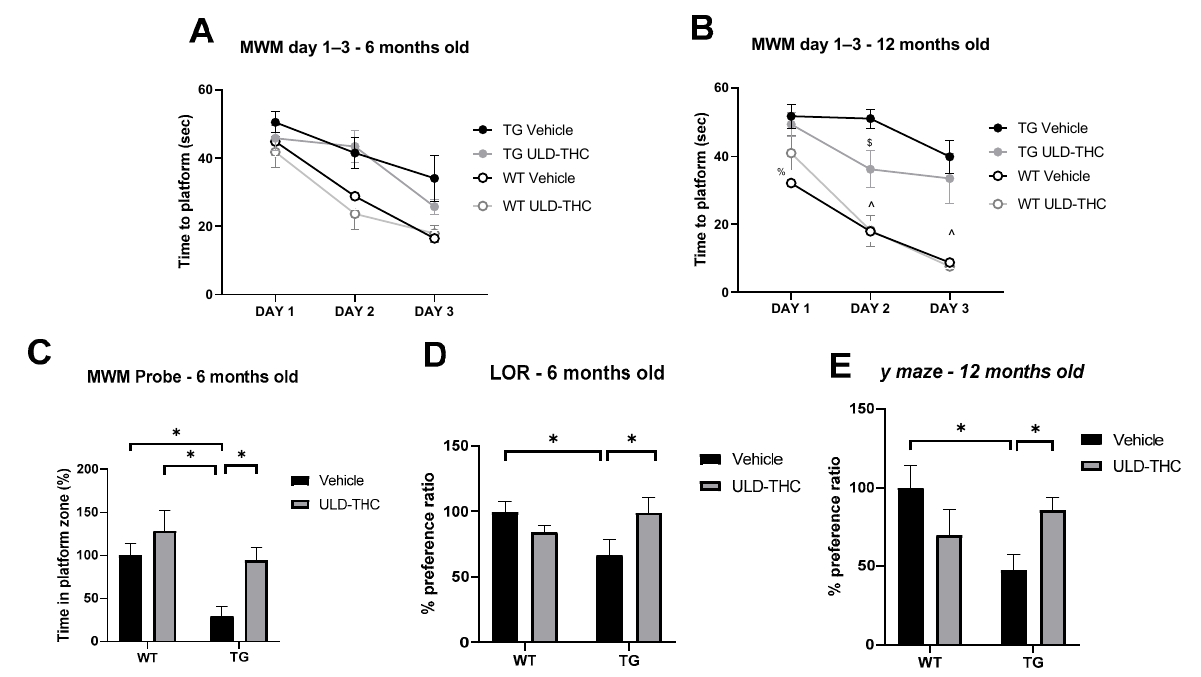
Figure 1. Cognitive improvement after ULD-THC. The learning of AD mice was impaired in the Morris water maze (indicative of learning ability and spatial memory) compared to WT mice, and the ULD-THC treatment alleviated this impairment at 6 months ( A ) and 12 months ( B ). On the probe phase on day 4 ( C ), 6-month-old WT mice spent significantly more time at the platform zone than AD mice, indicating the impaired long-term memory acquisition of AD mice. Importantly, ULD-THC-treated AD mice also spend more time than non-treated AD mice. In the novel location recognition test at six months ( D ), there were significant differences between the groups in long-term associative-spatial memory. Performance was impaired in AD mice compared to WT mice. Importantly, AD-treated mice exhibited a better performance compared to non-treated AD mice and spent significantly more time sniffing the object in the new location. According to the Y-maze, short-term spatial memory ( E ) was impaired in 12-month-old AD mice compared to WT mice. Importantly, treated AD mice exhibited better performance than vehicle-treated AD mice and spent significantly more time in the new arm. * indicates p > 0.05. ^ indicates the difference between WT groups and TG groups. %—Difference between WT control and TG groups. $—Difference between TG treated and TG control groups. Data in graphs ( C – E ) are presented as % from WT. n = 7–10. Mean ± SEM.